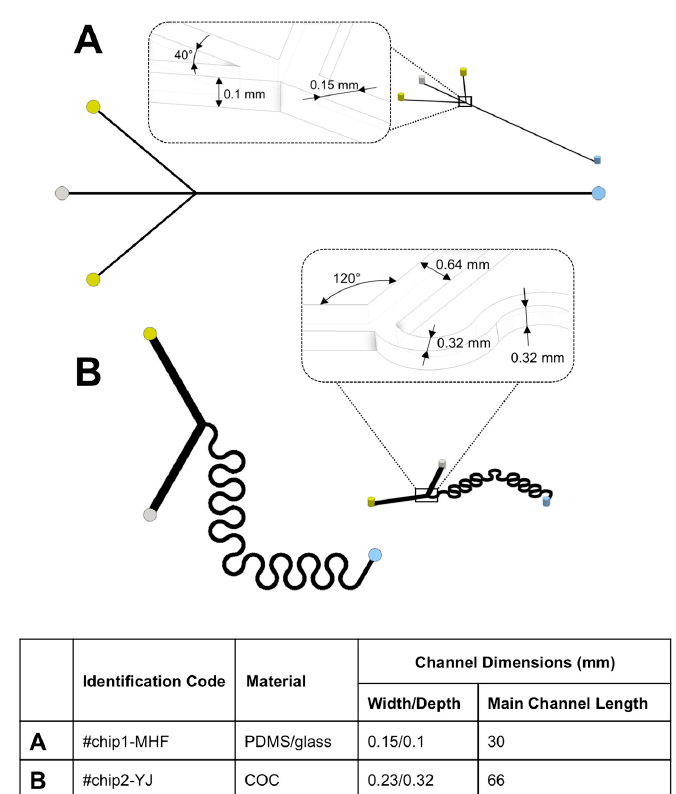
Figure 1. Schematic showing the geometry of the microfluidic chips employed in the present study. ( A ) #chip1-MHF was characterized by a cross flow geometry; while ( B ) #chip2-YJ was characterized by a “Y” shape geometry. The constitutive materials of the chips and the dimensions of the main channel (i.e., located after the junction between the inlet channels) are also